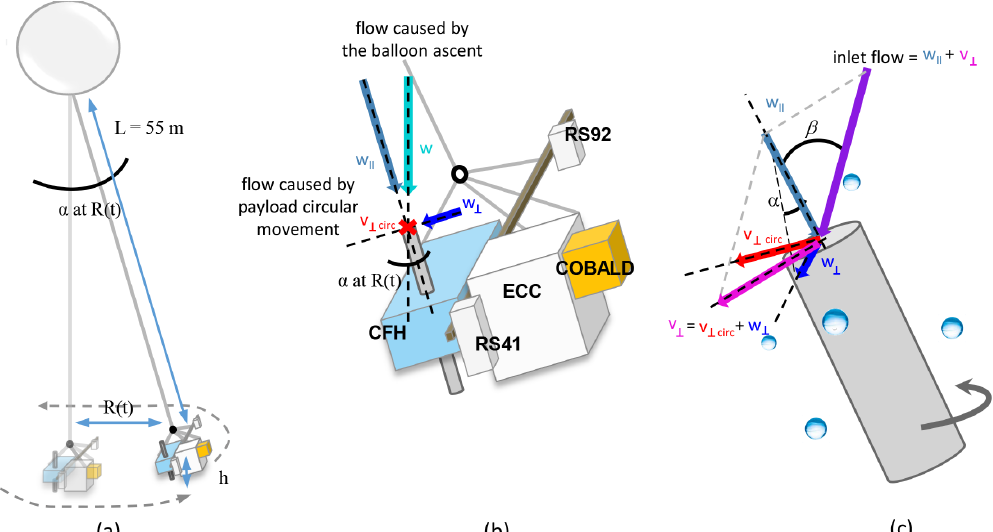
Figure 6. (a) Schematic of balloon and payload (not to scale). Payload is connected to the balloon by a 55m long lightweight nylon cord. Payload oscillates with tilt angles α up to 25 ◦ during ascent. (b) Schematic of payload with the two radiosondes (RS41 and RS92) and the three instruments (CFH, ECC Ozone and COBALD) and of intake flow geometry due to balloon ascent and payload circular movement. The flow caused by the vertical balloon ascent ( w ) has a component parallel to the intake tube ( w || ) and a component perpendicular to the tube walls ( w ⊥ ). Circular movement of the payload adds an additional component ( v ⊥ , circ ) in the plane perpendicular to the intake tube. (c) The total velocity perpendicular to the tube becomes v ⊥ = v ⊥ , circ + w ⊥ . The total perpendicular velocity v ⊥ and the parallel component of the ascent velocity to the intake tube w || determine the inlet flow and the impact angle β .